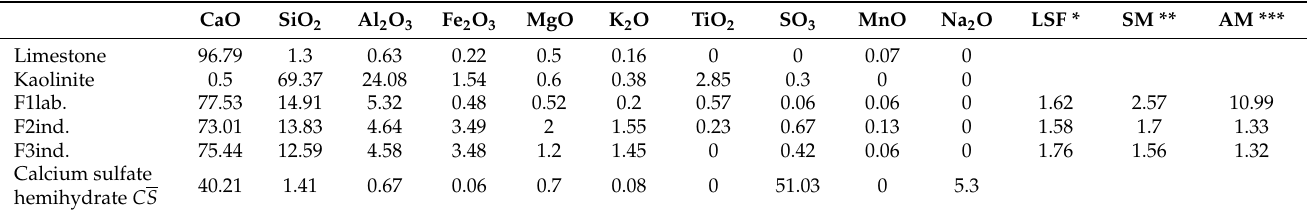
Table 1. Chemical composition of the industrial and laboratory premix